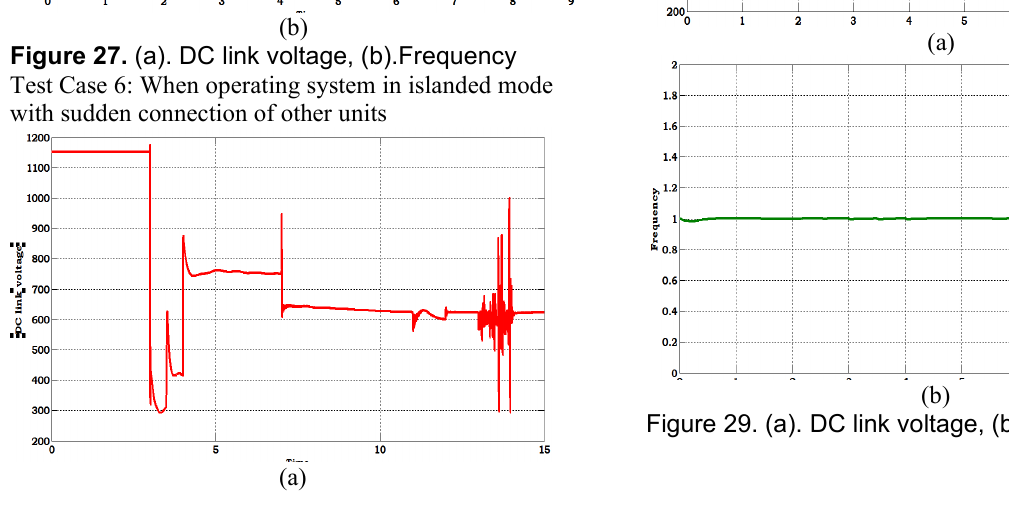
Table 2. Comparison of Fuzzy logic controller, ANN, MPC controllers